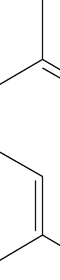
Figure 1: Structure of